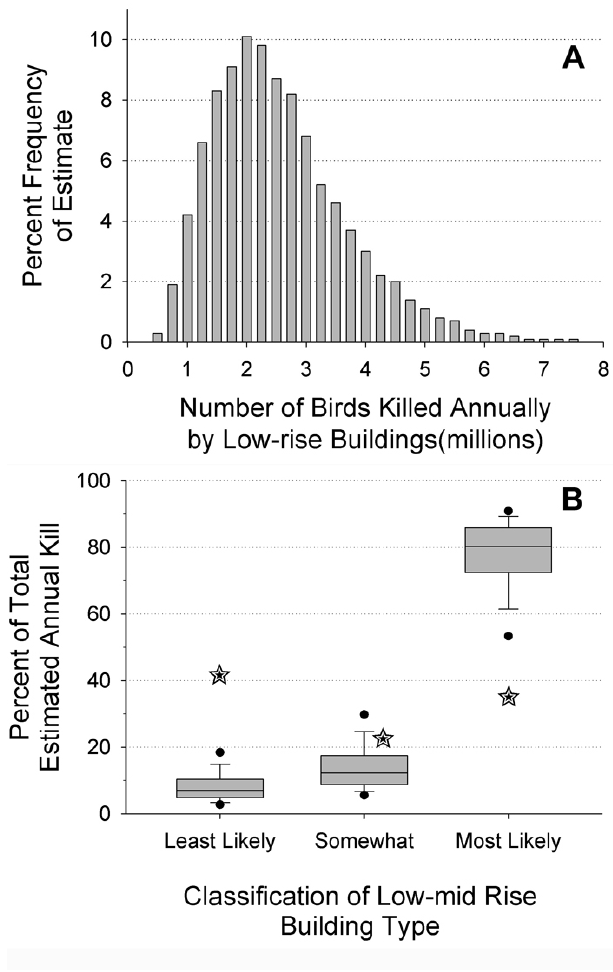
Fig. 5 . Estimates of bird mortality in Canada caused by collisions with windows in low-rise commercial and institutional buildings. Panel A shows results as a frequency distribution from all iterations (see Methods). Estimates were rounded to the nearest 0.25 million for graphing and the graph was truncated at 8 million because higher estimates were not visible. Panel B is a box and whisker plot showing percent of the total annual mortality contributed by each of the three classes of buildings in the low-mid rise commercial building category. The stars above or below each box correspond to the percentage of the total buildings represented by that class (42%, 24%, 35%, respectively). See Fig. 4 for explanation of the box